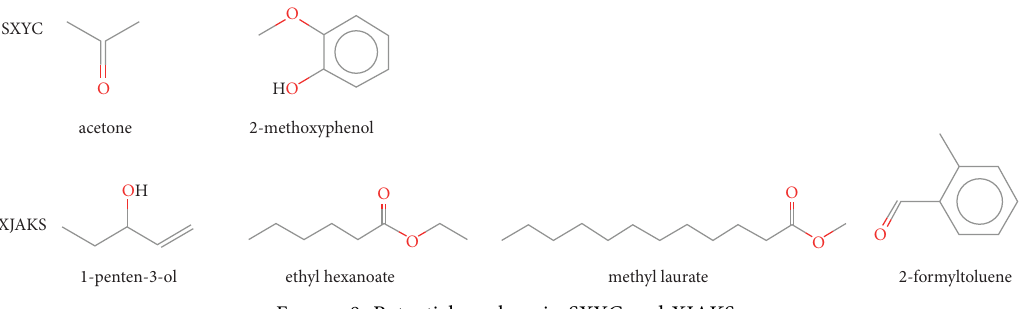
Figure 8: Potential markers in SXYC and